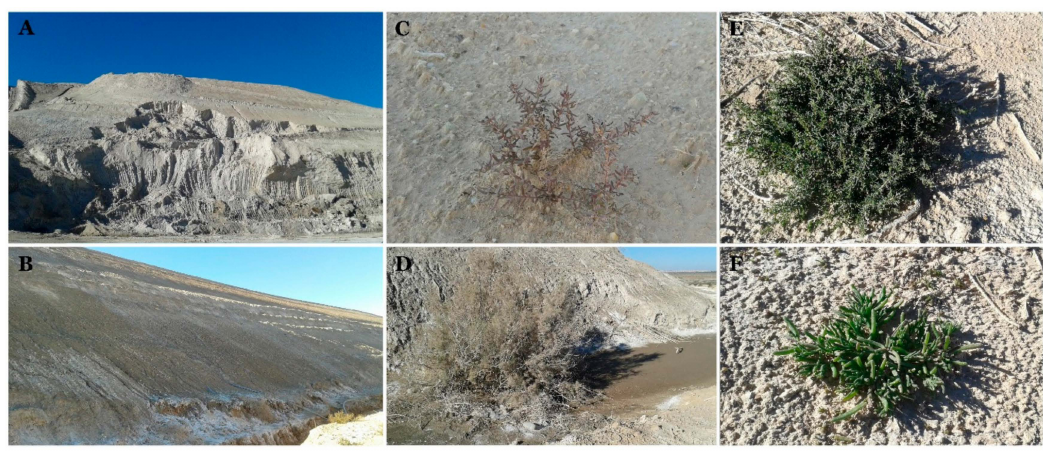
Figure 1. Phosphogypsum piles in CPG, Gafsa, Tunisia ( A , B ), Arthrocnemum indicum , Suaeda fruticosa , Suaeda mollis and Mesembryanthmum nodiflorum growing in areas contaminated with phosphogypsum in the vicinity of the PG piles ( C – F